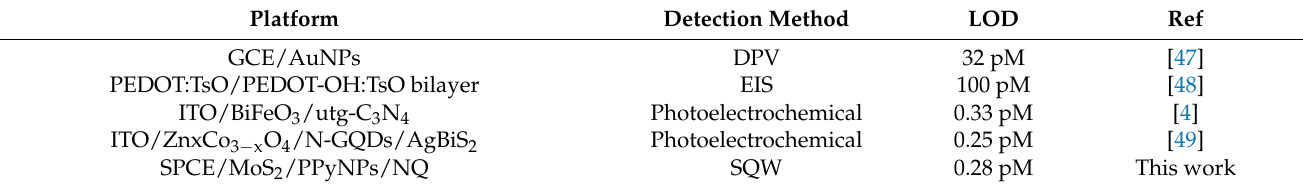
Table 1. Properties of various biosensors developed for ampicillin.